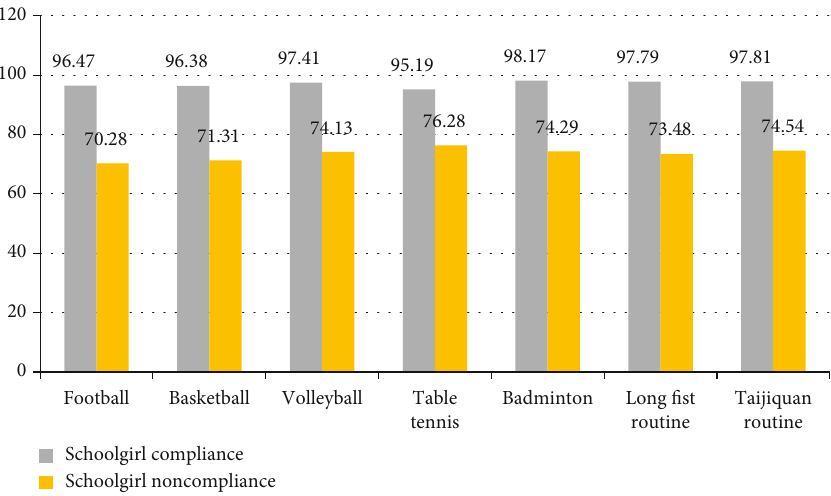
Figure 4: Comparison of physical fi tness test compliance rate of girls in di ff erent